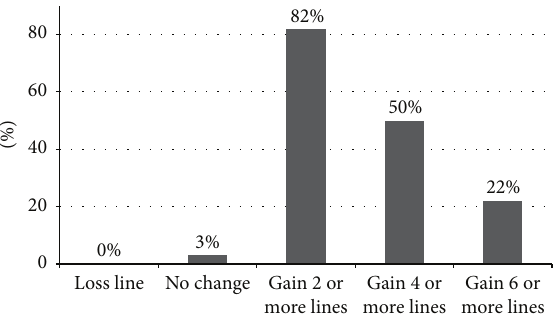
Figure 1: Line gains in Snellen with contact lens (difference between BCLCVA and